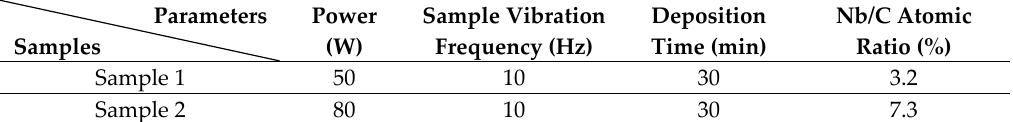
Table 1. Atomic% of niobium on the Nb 2 O 5 /graphene samples.